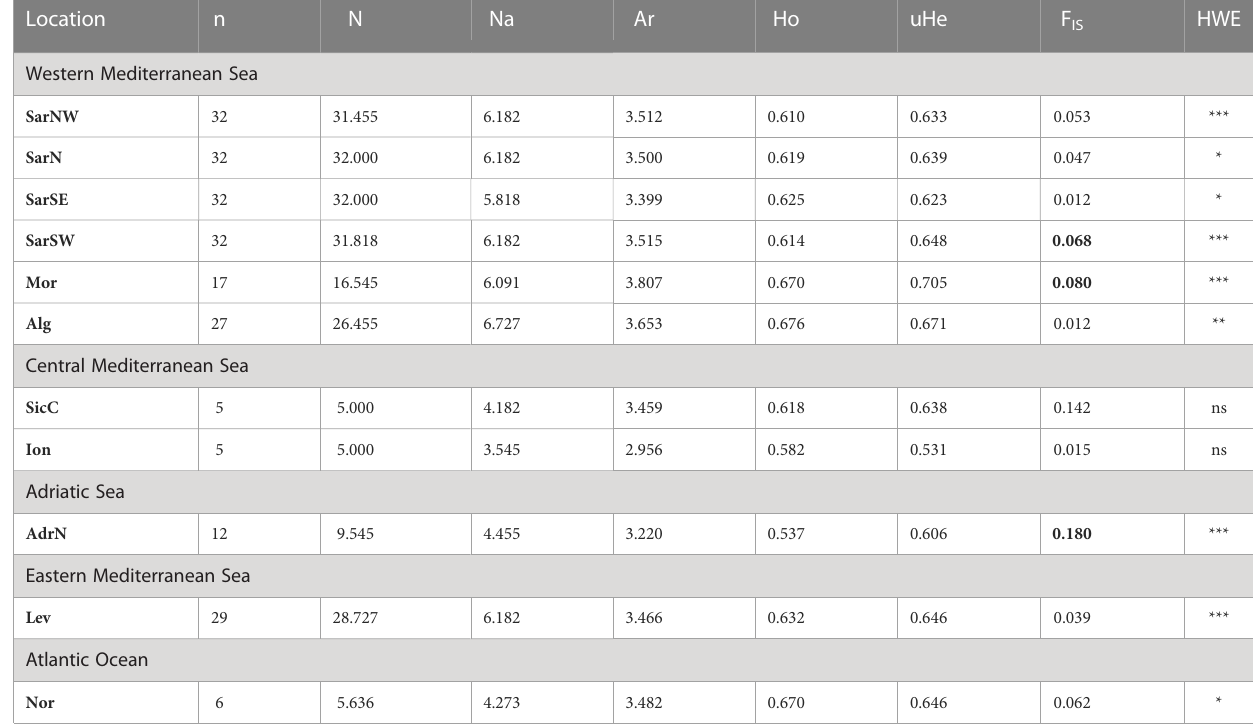
TABLE 1 Descriptive statistics of Scyliorhinus canicula population samples.